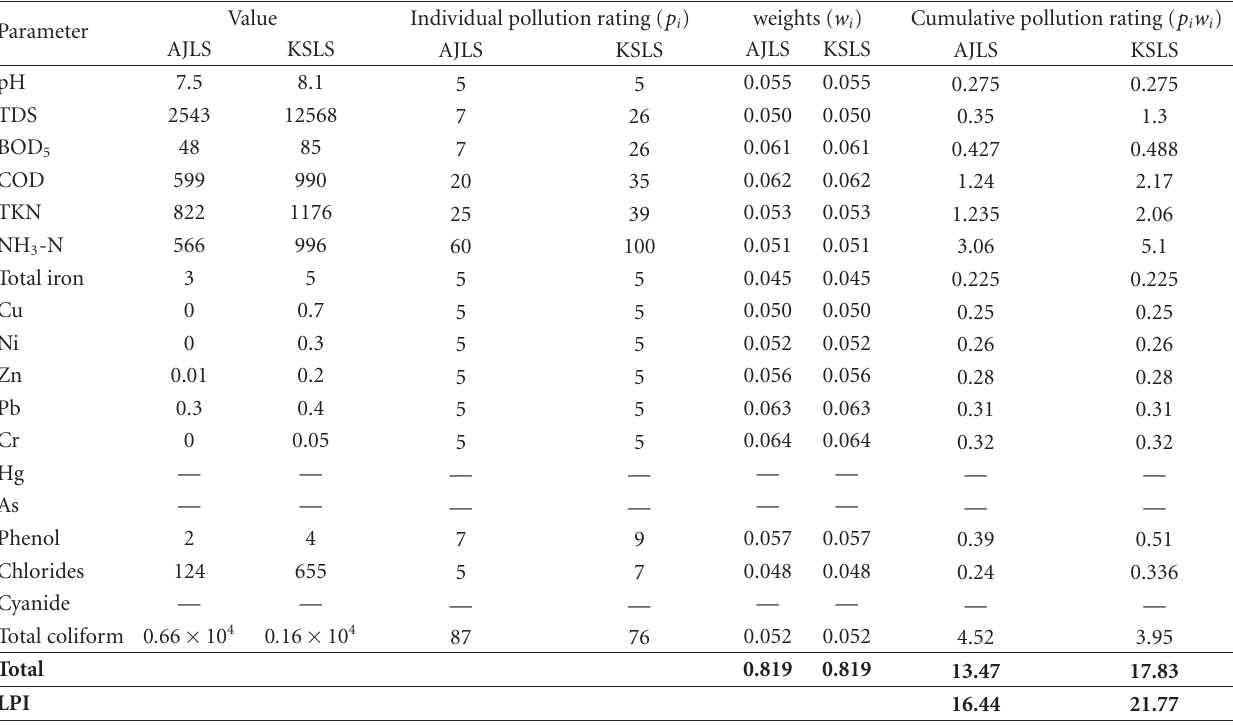
Table 2: Characteristics and LPI of leachate from AJLS and KSLS ∗